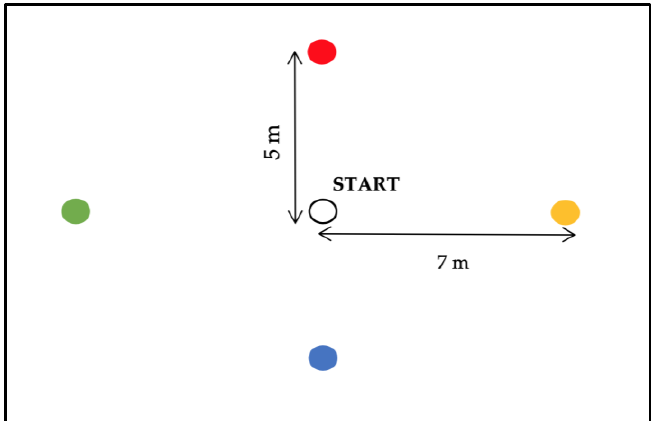
Figure 1. Schematic representation of the Coimbra Reactive Agility Soccer Test